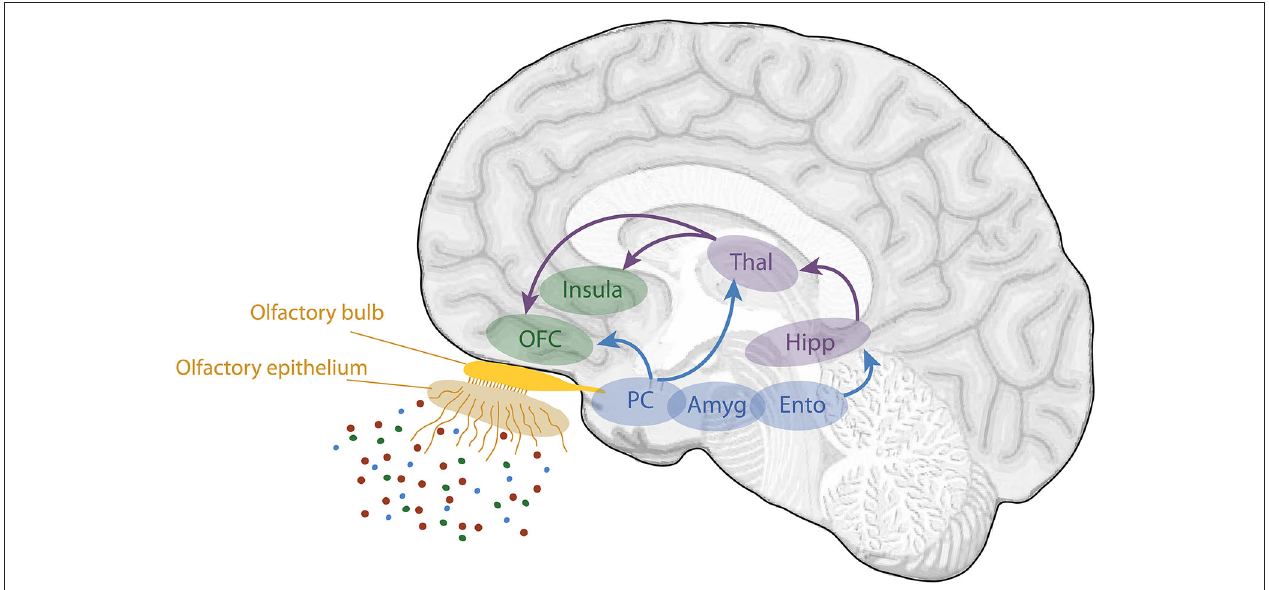
FIGURE 1 | Schematic view of the human olfactory system . The primary and secondary olfactory cortices are represented in blue and green, respectively. Amyg, amygdala; Ento, entorhinal cortex; Hipp, hippocampus; OFC, orbitofrontal cortex; PC, piriform cortex; Thal, thalamus (adapted from Royet et al.,